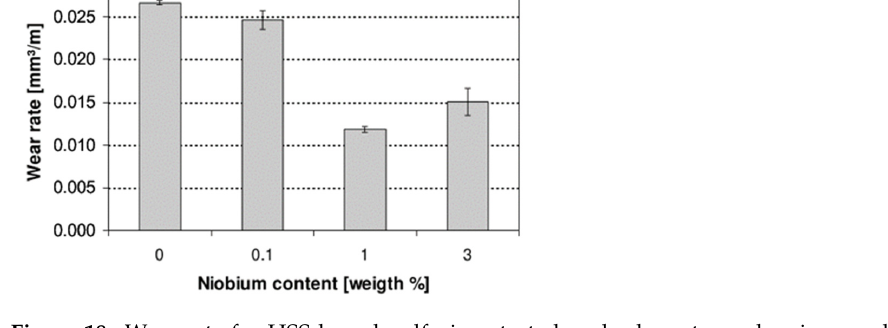
Figure 18. Wear rate for HSS laser hardfacings tested under low-stress abrasion conditions as a function of the niobium content [66].